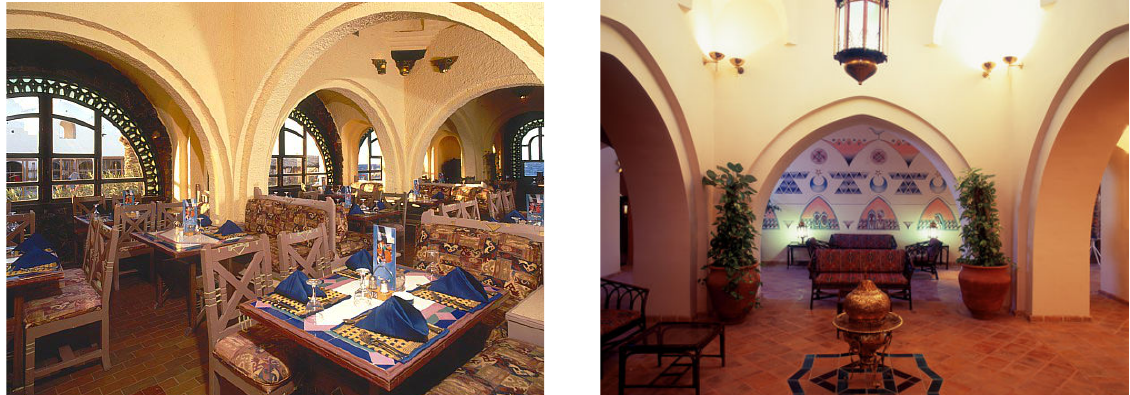
Figure (2): Example of Décor department Prep. year students Artwork at the faculty of Fine Arts. Source: photographed by the authors from the kept projects of décor department library.